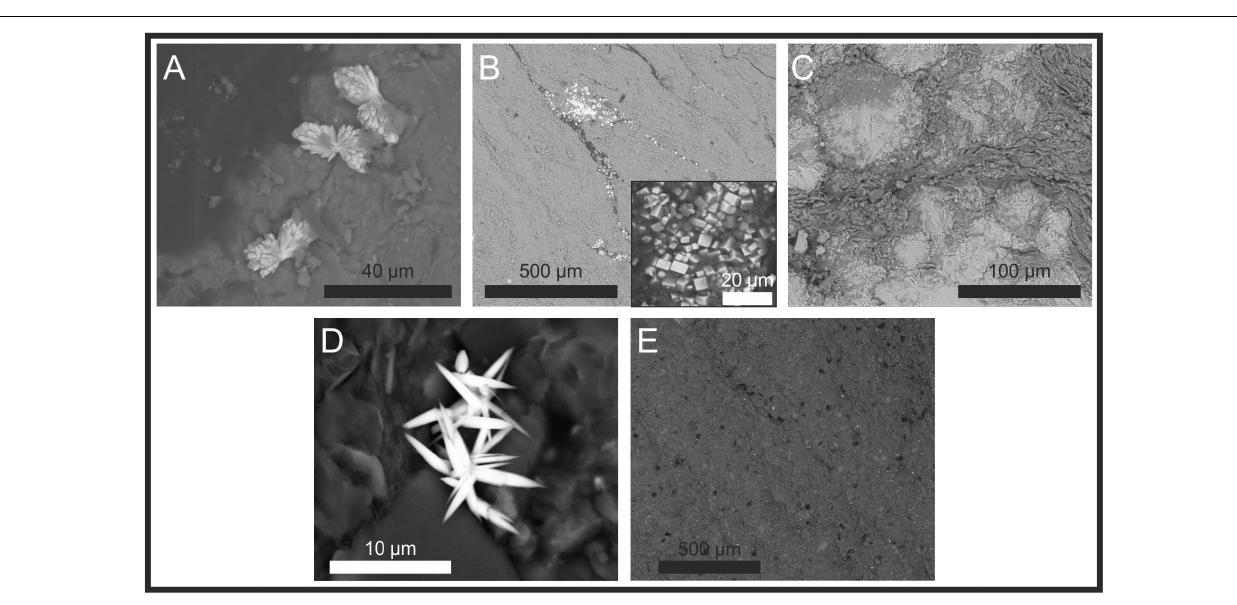
FIGURE 8 | Back scattered electron microscope (BSEM) images from Melbourne 1 (see Figure 5 for locations of samples and Table 2 for depths). (A) Sample SSK69728 showing dumbells of barite, (B) Sample SSK69729 showing sub-horizontal veins of carbon and micro-fractures across the surface. Sulfides (pyrite and barite) are associated with the carbon. Insert shows the euhedral nature of the pyrite, (C) Sample SSK69730 showing detail of the iron oxide nodules, (D) Sample SSK69731 showing acicular crystals of barite, (E) Sample SSK69732 showing fine-grained laminations and micro-fractures, and the “polka-dot” texture defined by carbon